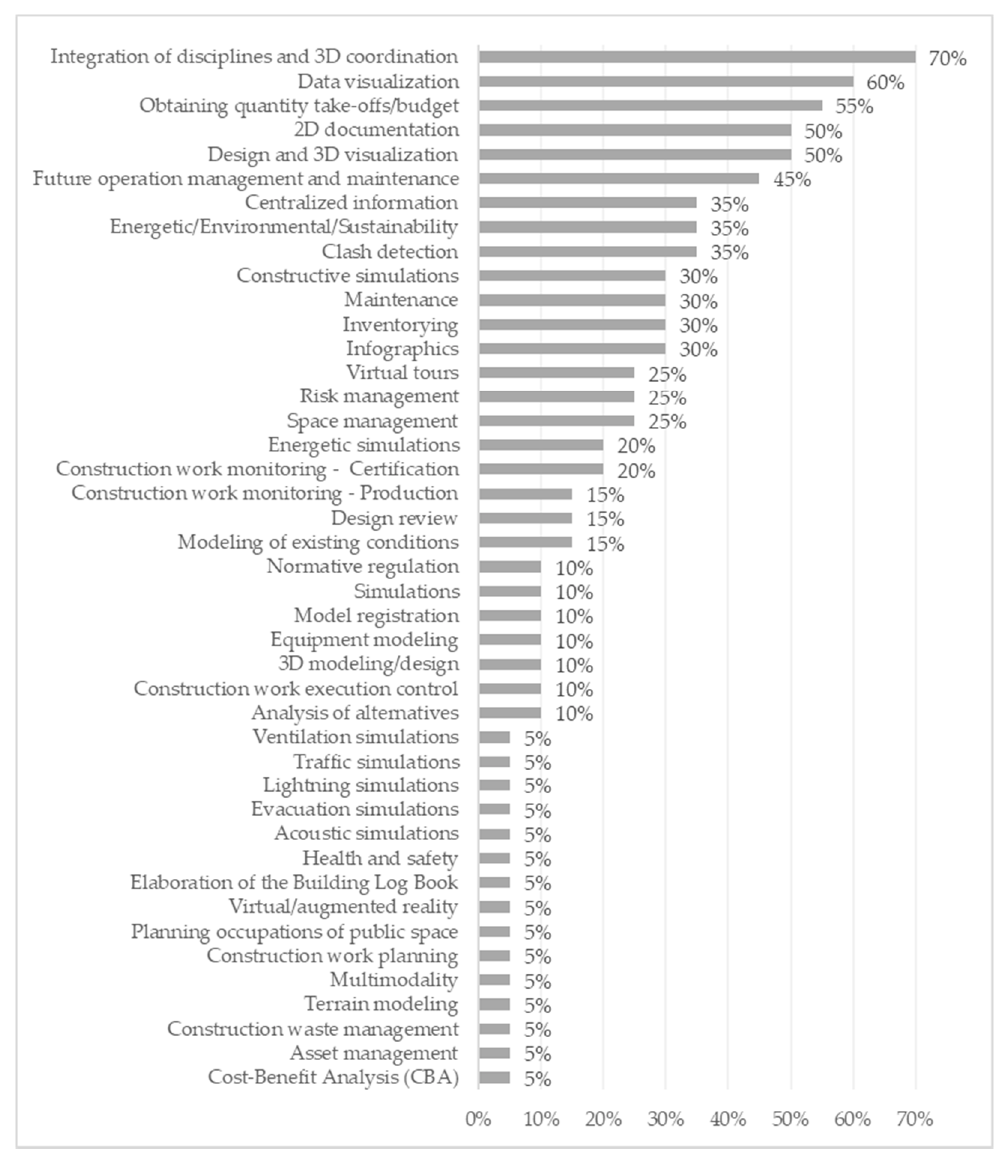
Figure 8. BIM uses identified in the analyzed contracts.